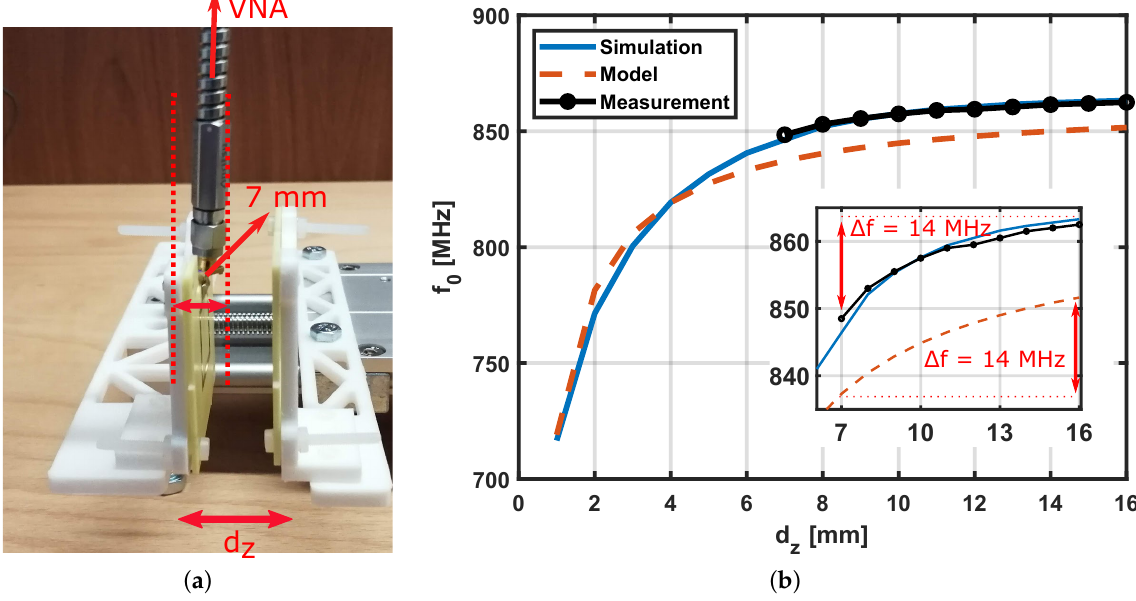
Figure 14. ( a ) Experimental setup showing the minimum value of d z that can be measured due to the size of the soldered SMA connector. ( b ) Comparison between the resonant frequency of the SR obtained from numerical simulations, equivalent circuit model, and experimentally. Results are plotted for a sensor prototype with L p = 22 mm, L tag = 18 mm, w = 1.5 mm, s = 2 mm, and N = 2 turns while varying d z